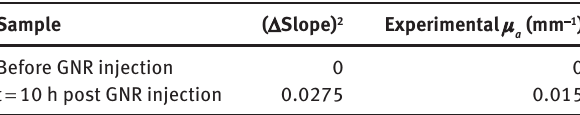
Table 1: The experimental absorption coefficients of GNRs in the tumor before and 10 h post injection.